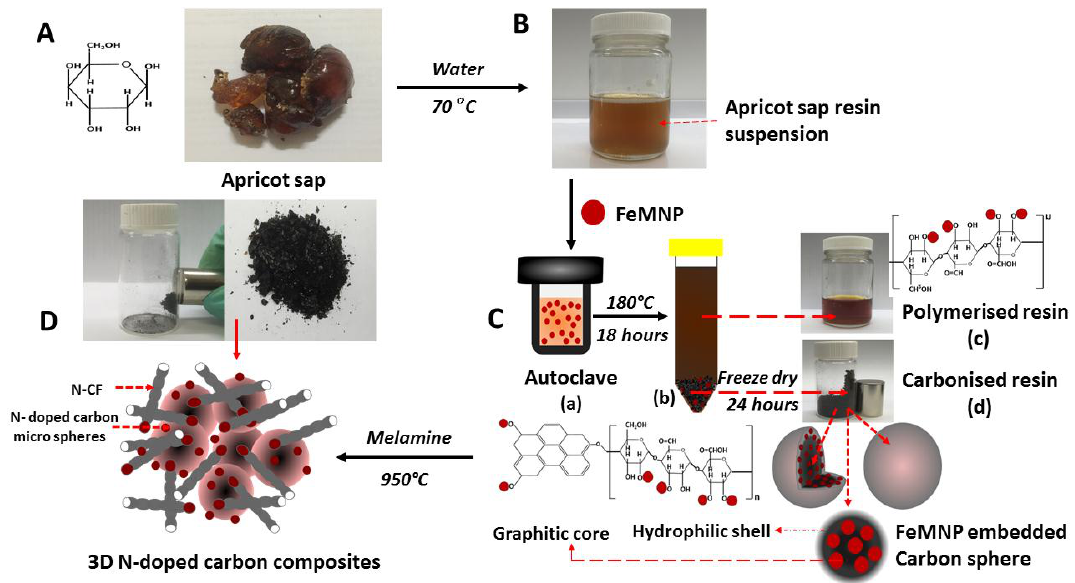
Scheme 1. Schematic procedure of three-dimensional (3D)-integrated N-doped carbon microspheres (CMS)